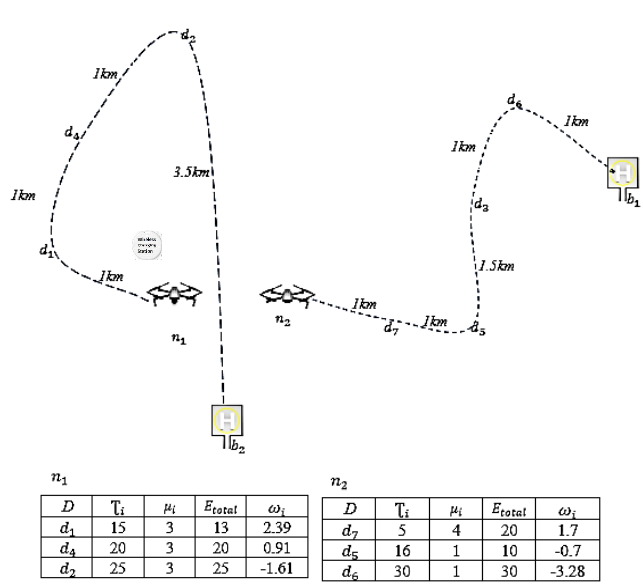
Figure 2. Optimized flight paths of the two drones in Figure 1 based on Heuristic Flight Path Planning (HFPP).